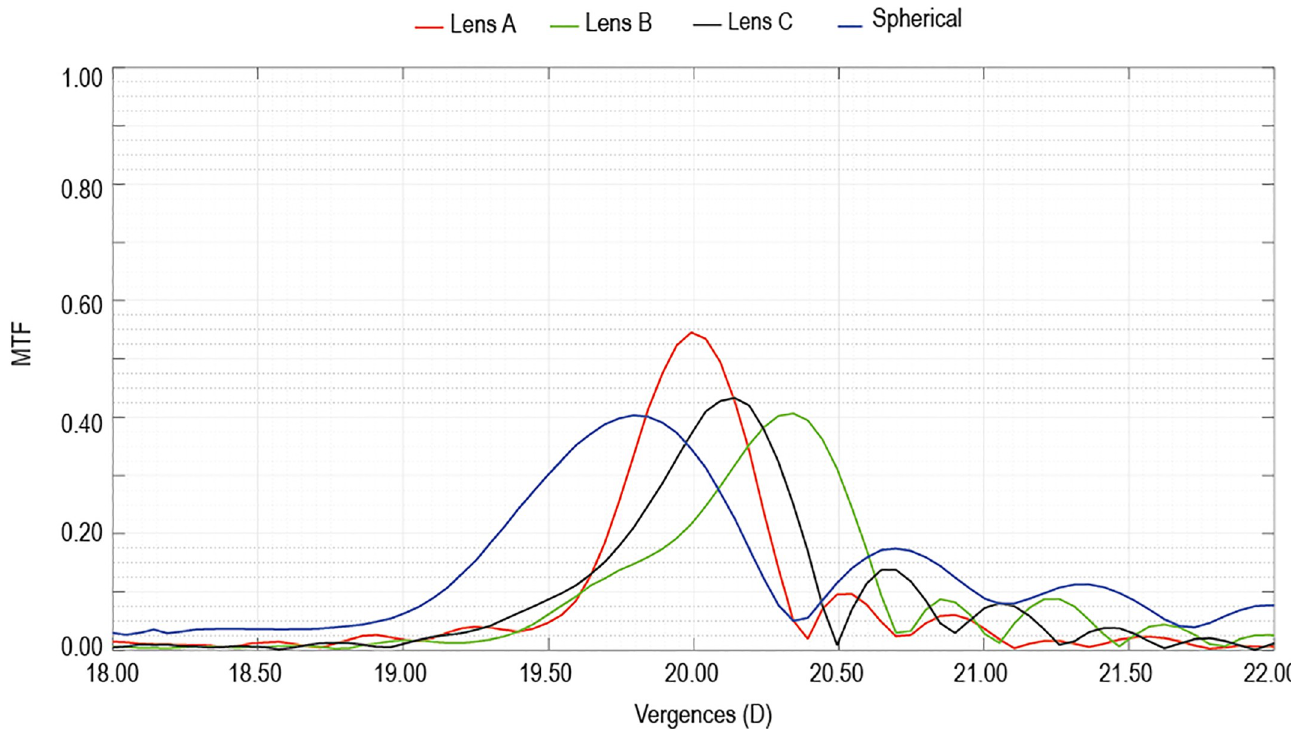
Fig 5. Experimental TF-MTF (3.00 mm pupil diameter and 100 cycles per degree) for a refractive power of +20.00 D tested in-vitro with the PMTF optical bench.